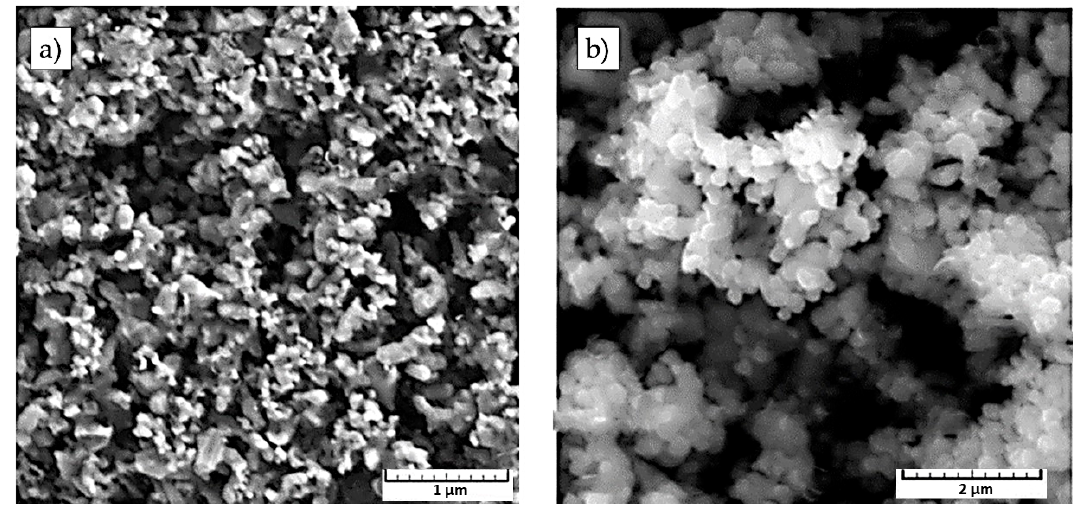
Figure 1. Micrographs of starting powders: ( a ) field emission scanning electron microscope (FESEM) micrograph of tungsten carbide (WC) DN 4-0; ( b ) scanning electron microscope (SEM) micrograph of